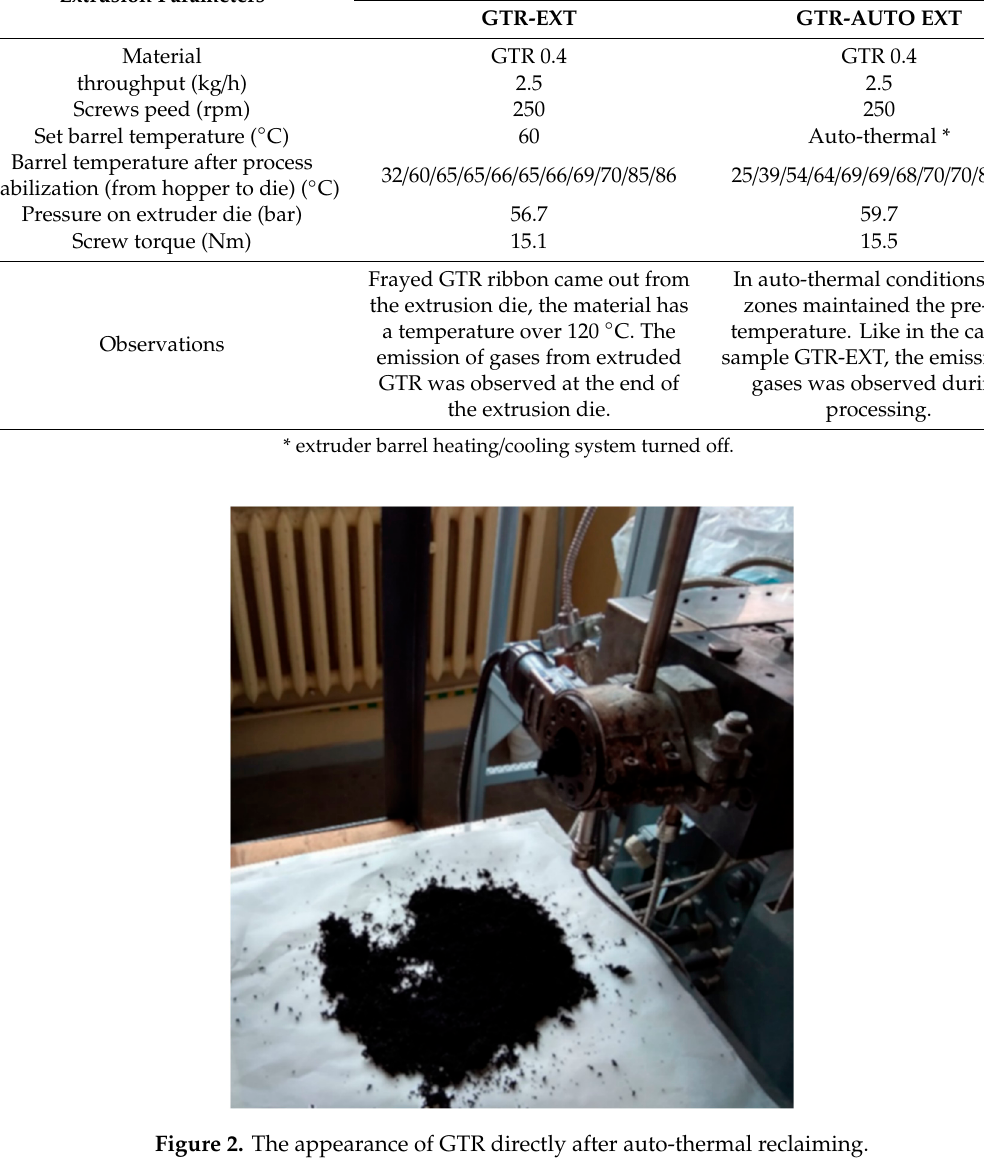
Table 1. Extrusion conditions of ground tire rubber (GTR).